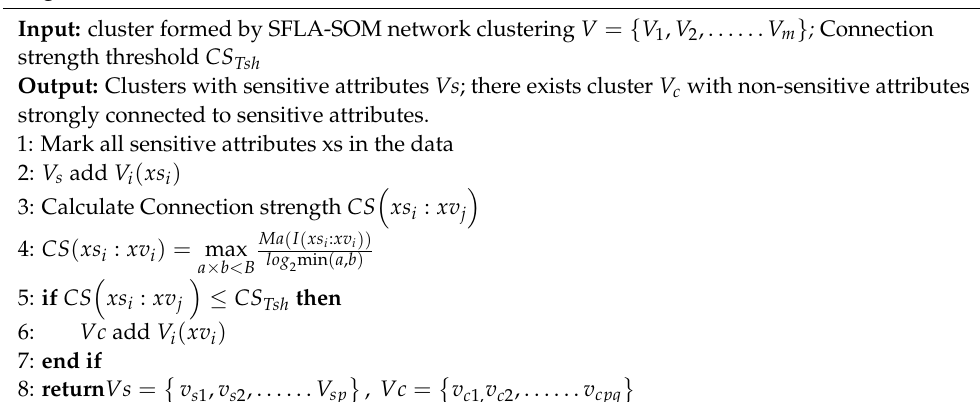
Algorithm 4 Attribute correlation determation